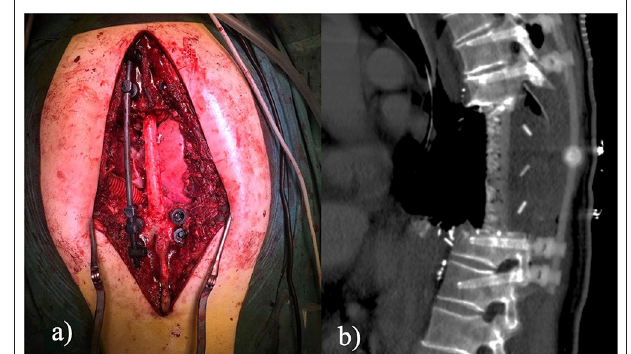
FIGURE 3 | (a) Open posterior approach. The figures show the results of a triple en bloc vertebrectomy. Pedicle screws were inserted at two levels above and two levels below the pathologic vertebrae; (b) Sagittal CT scan. The figure shows the final result after tumor removal and 360 ◦ fixation. Instrumentation is radiolucent to consent radiologic follow-up.